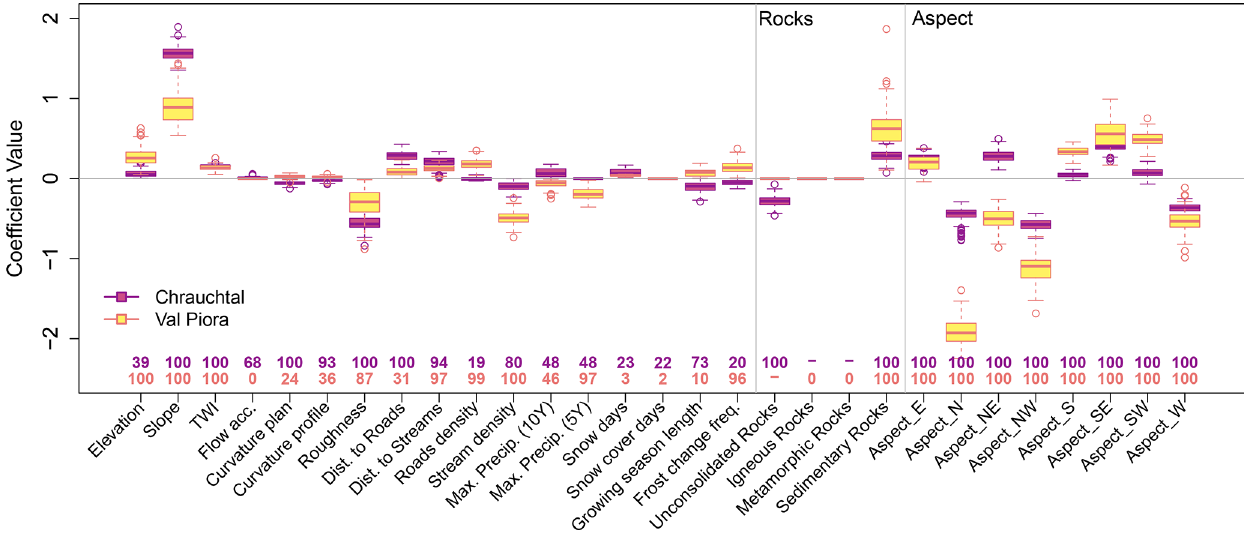
Figure 7. Boxplots (with whiskers and outliers) showing the coefficient range with 100 repetitions. Numbers above variable names indicate the number of times it was selected for the model. Boxes show the interquartile range (25th and 75th percentile), and the line indicates the median of the coefficients. Chrauchtal and Val Piora are selected from 10 study sites as examples. Table 3. Confusion matrix derivations using 0.5 for the prediction threshold. Perfect scores are accuracy = 1, bias = 1 (above 1 is overpre- dicted, while below 1 is underpredicted), true positive rate (TPR) = 1 and false positive rate (FPR) = 0. Site names are abbreviated as follows. A: Arosa; B: Baulmes; C: Chrauchtal; H: Hornbachtal; R: Rappetal; T: Turbachtal; U: Urserental; VC: Val Cluozza; VE: Val